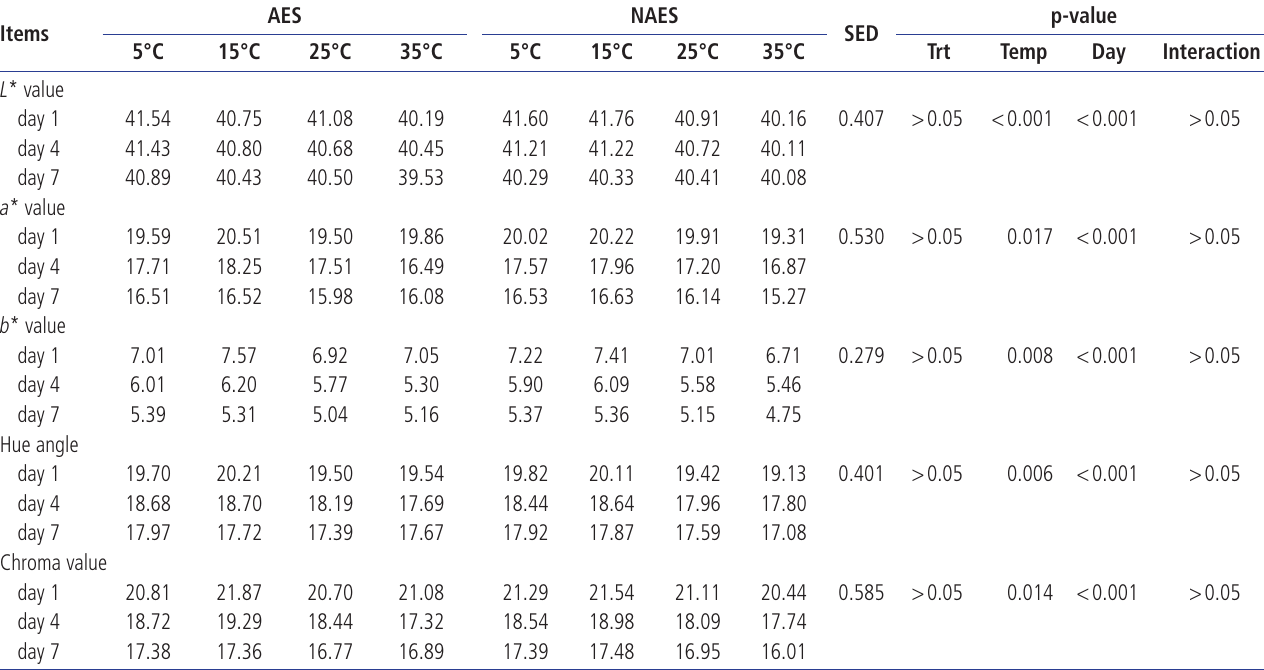
Table 3. Effect of AES and various pre-rigor holding temperature (for 3 h) methods on the color stability (48 h post mortem) of beef M. longissimus lumborum samples